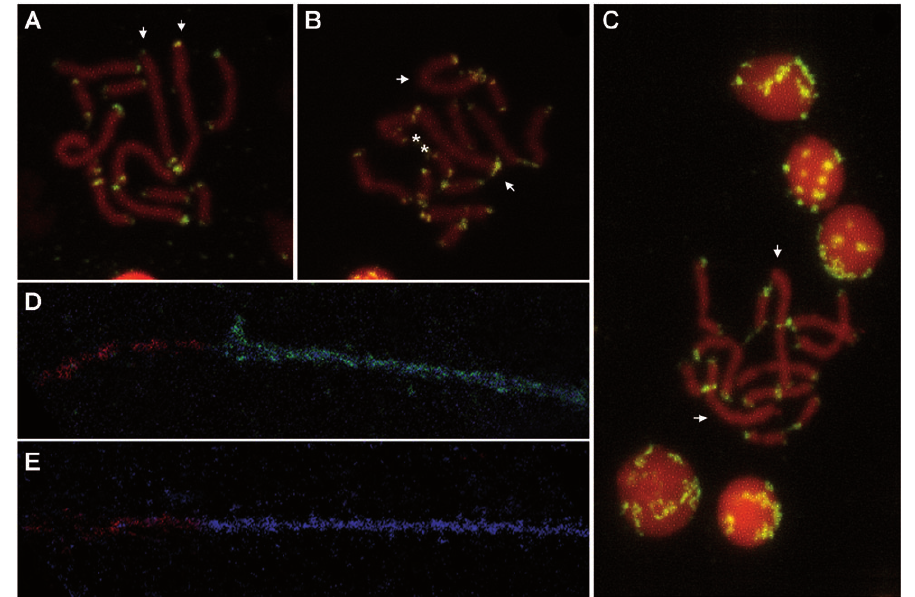
Figure 2 The aphid M. persicae is one example of an insect telomere with canonical telomerase and (TTAGG) probe (A , B) evidenced that each chromosomal end consists of an array of the TTAGG motif, not only in a standard FITC-labeled (TTAGG) n karyotype (A), but also in metaphase plates where a fragmentation occurred suggesting that a de novo synthesis of telomeres occurred (B). In view of the presence of the MpR subtelomeric satellite at each autosome subtelomeric end (C), it has been possible to distinguish standard (D) and neo-synthesized telomere (E) by fi ber FISH. In standard telomere, FISH on DNA fi bers stained with DAPI (in blue) showed the presence of the TTAGG array (in red due to the use of a TRITC-labeled telomeric probe) near the cluster of the MpR subtelomeric satellite (labeled in green in view of the use of a FITC-labeled probe) (D). The MpR subtelomeric array is absent from de novo telomeres (E). Asterisks indicate the chromosomal ends involved in fragmentation. Arrows indicate X